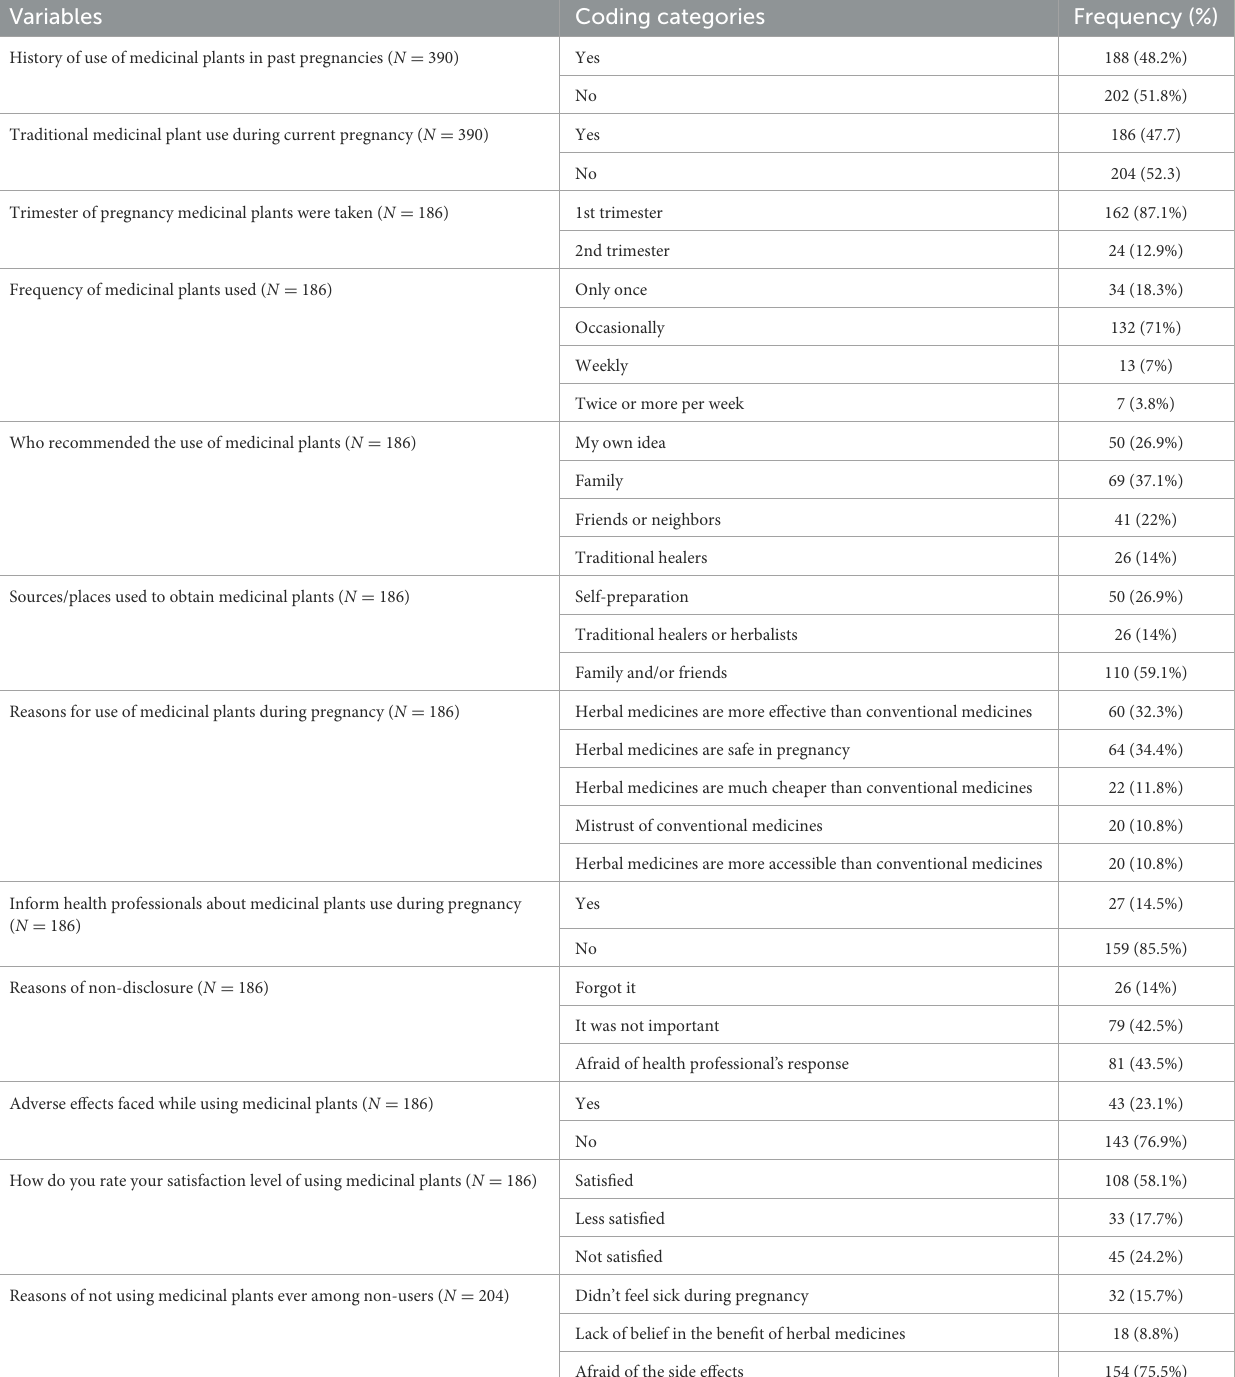
TABLE 3 Patterns of traditional medicinal plant utilization by the study participants in east Gojjam Zone, Northwest Ethiopia, 2021 ( N = 390). Variables Coding